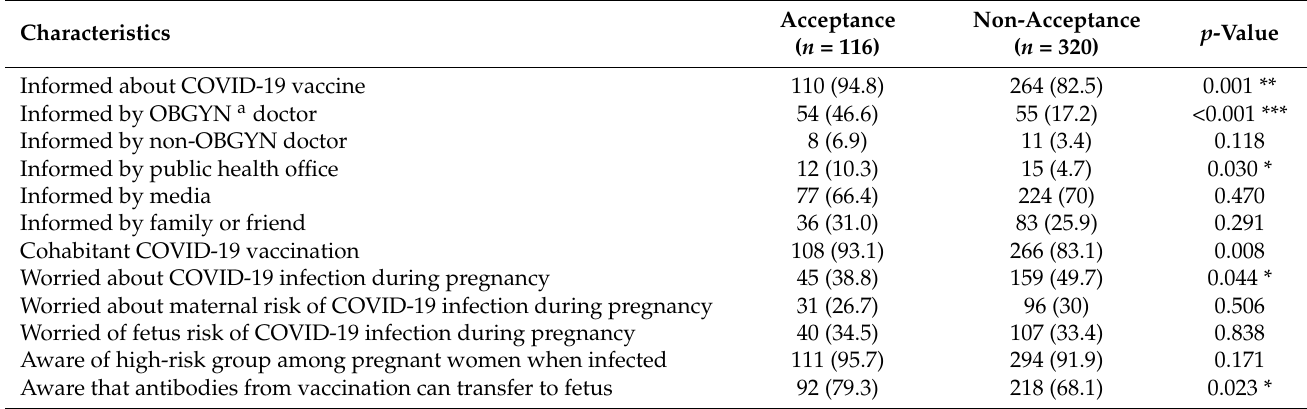
Table 2. COVID-19-related characteristics regarding COVID-19 vaccine